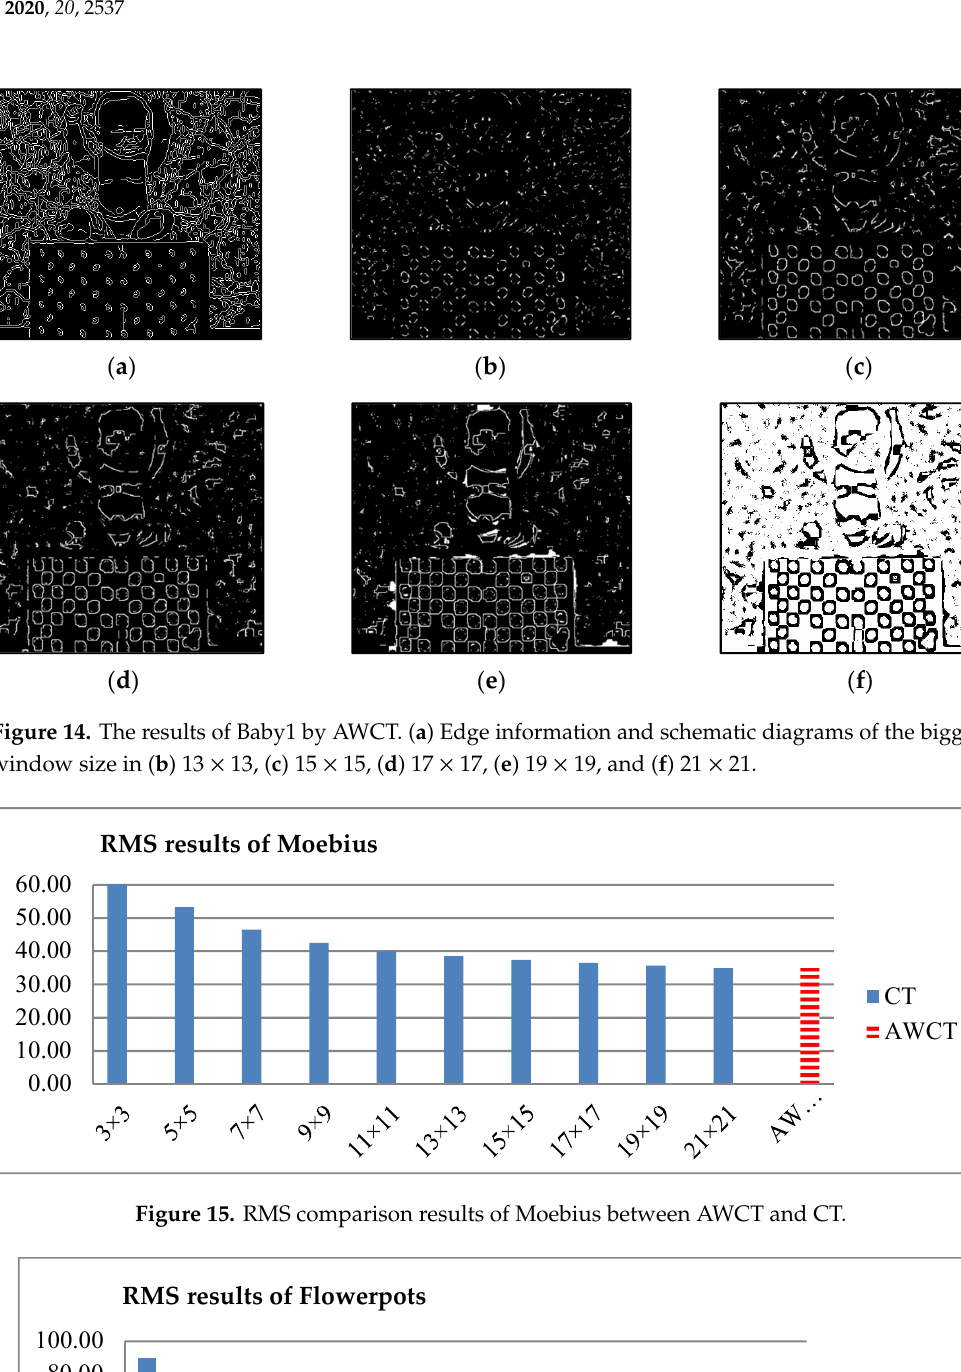
Figure 13. The results of Midd1 by AWCT. ( a ) Edge information and schematic diagrams of the